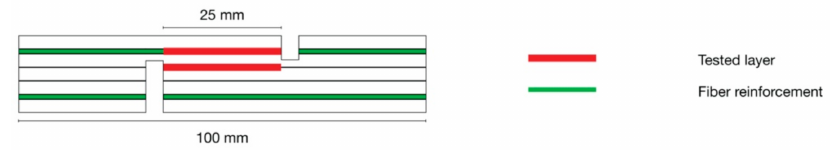
Figure 3. Shear test specimen made of five veneer plies both sides fiber reinforced.